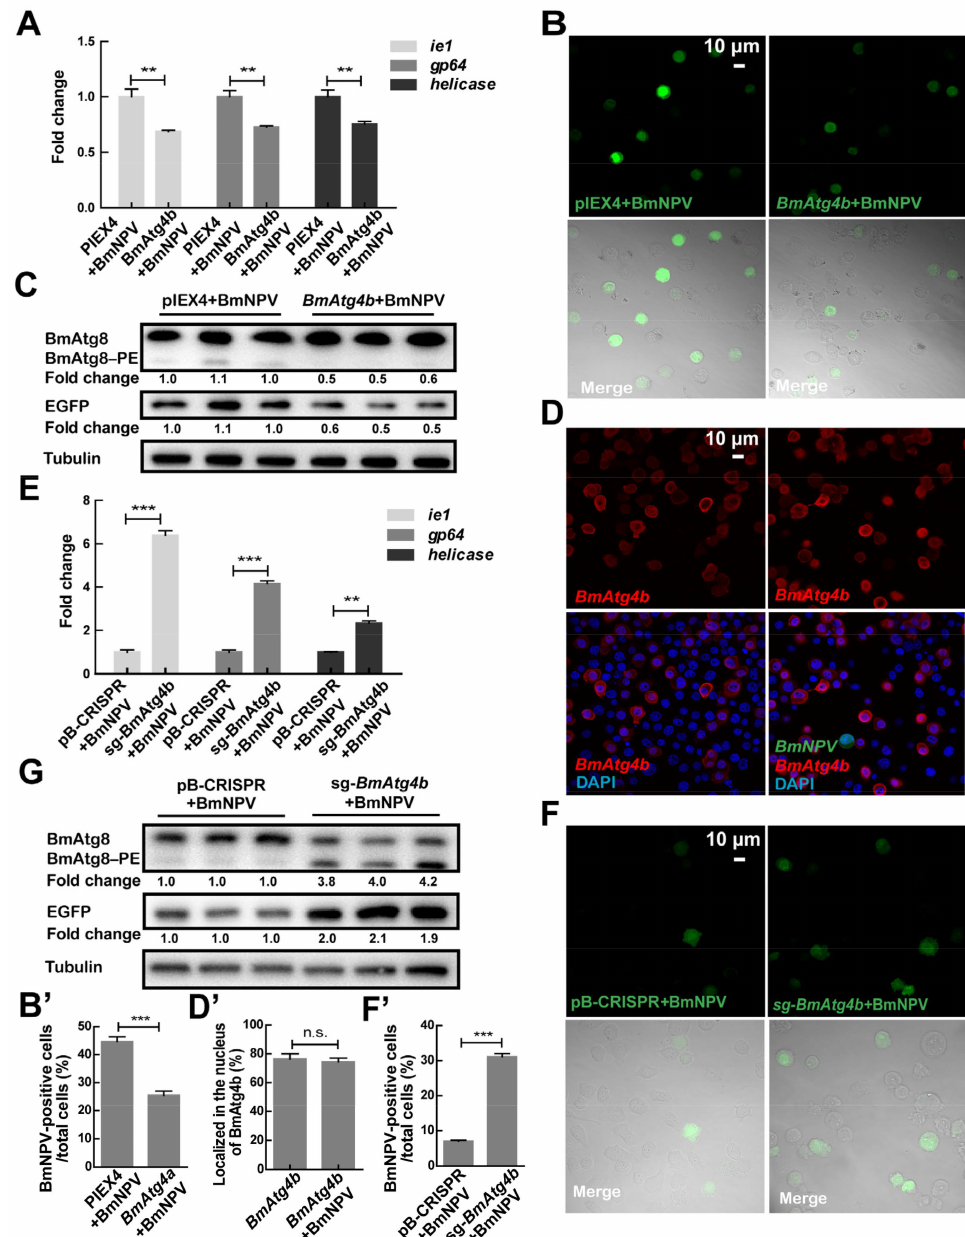
Figure 4. Effect of BmAtg4b on the proliferation of BmNPV in BmN cells. ( A ) The copies of BmNPV genes, including ie1 , gp64 , and helicase, were detected by qPCR after overexpression of BmAtg4b for 48 h, followed by BmNPV infection for a further 48 h. ( B ) The green fluorescence of BmNPV- EGFP was observed after the overexpression of BmAtg4b . ( B’ ) Quantification of the EGFP-positive cells in ( B ). ( C ) The protein levels of BmAtg8/BmAtg8–PE and the viral EGFP detected by WB after overexpression of BmAtg4b . Fold change means the variation of BmAtg8–PE and EGFP pro- tein levels in ( C ). ( D ) IF staining of the overexpressed BmAtg4b after BmNPV infection for 48 h. ( D’ ) Quantification of cells with the nuclear signal of BmAtg4b in ( D ) indicated by the percentage of cells stained with the BmAtg4b signal in the nuclei. ( E ) The copies of ie1 , gp64 , and helicase were detected by qPCR after knockout of BmAtg4b , followed by BmNPV infection for a further 48 h. ( F ) The green fluorescence of BmNPV-EGFP was observed after the knockout of BmAtg4b . ( F’ ) Quan- tification of the EGFP-positive cells in ( F ). ( G ) The protein levels of BmAtg8/BmAtg8–PE and the virus-expressed EGFP detected by WB after knockout of BmAtg4b . Fold change indicates the variation of BmAtg8–PE and EGFP protein levels in ( G ). ** p < 0.01, *** p < 0.001, n.s.: no